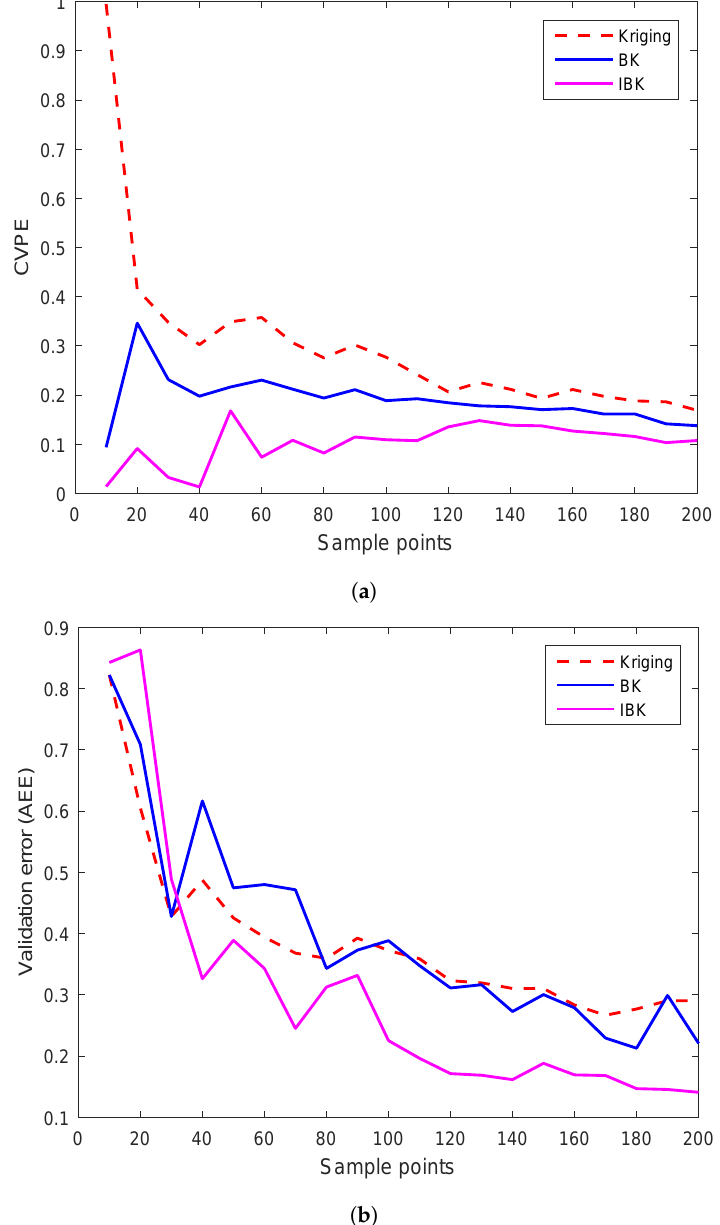
Figure 3. The relationship between flesh elements and thickness values. ( a ) Cross-validation predic- tion error of metamodels with different sample size. ( b ) Validation error of metamodels with different sample